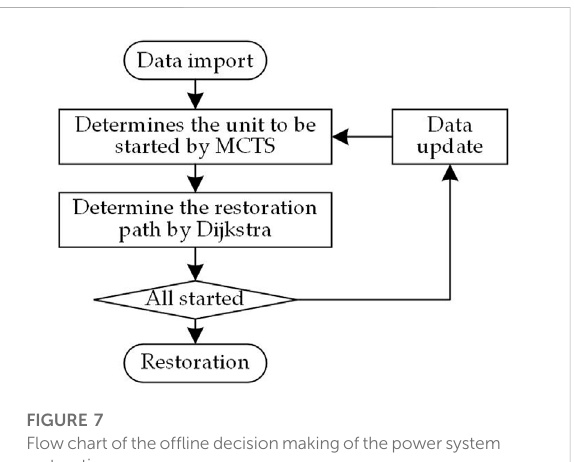
FIGURE 7 Flowchartoftheof fl inedecisionmakingofthepowersystem